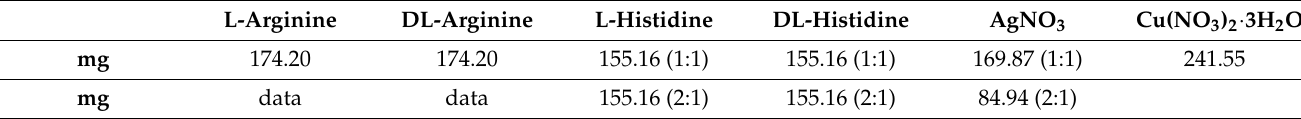
Table 2. Mass quantities of the materials used in the solid-state synthesis (expressed in mg). L-Arginine DL-Arginine mg